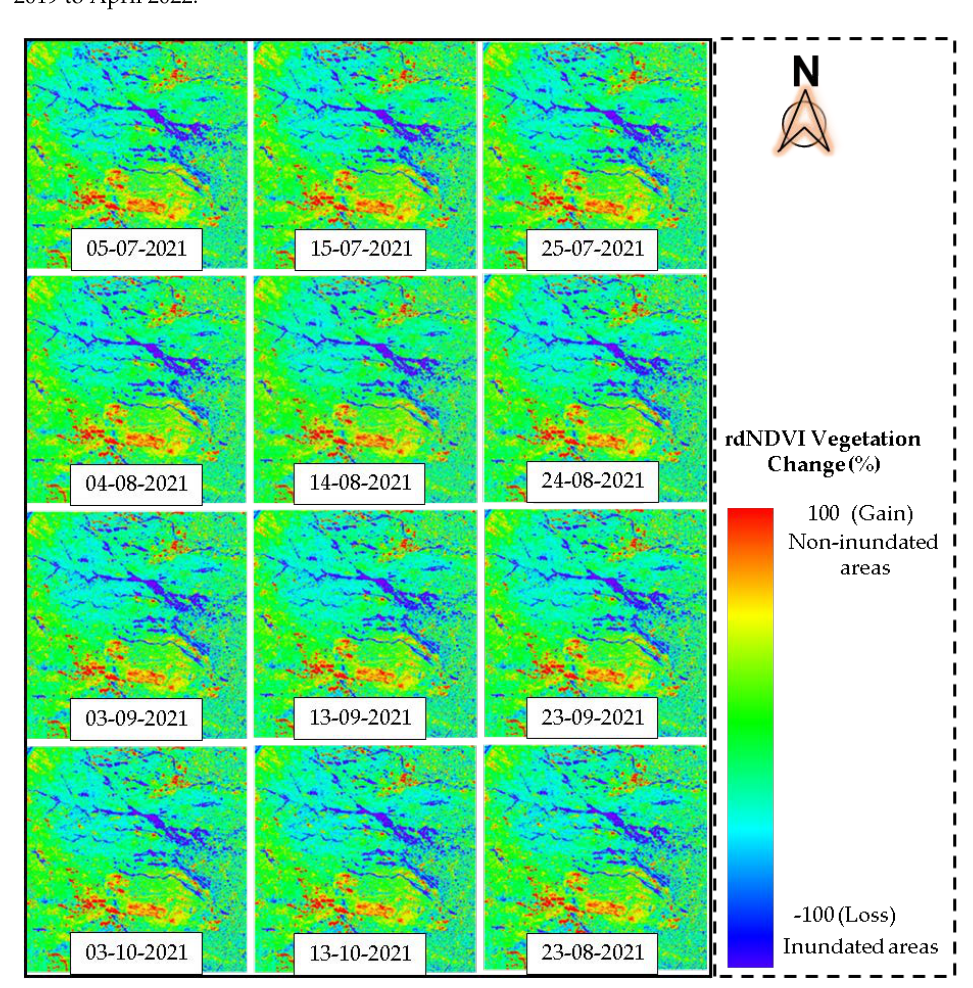
Figure 17. rdNDVI changes in Charikar after a one-year period .